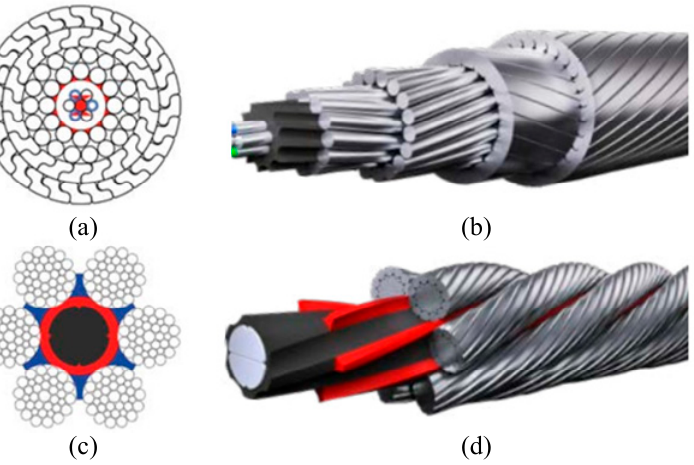
Figure 1. Main types and structure of wire rope. ( a ) Section of sealing wire rope; ( b ) Appearance of sealing wire rope; ( c ) Section of unsealed wire rope; ( d ) Appearance of unsealed wire rope.